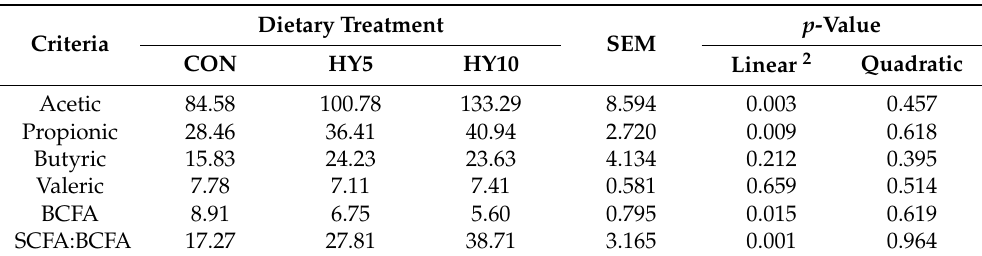
Table 7. Fecal short chain fatty acids ( µ mol/g of feces) contents of early weaned piglets fed HY- supplemented diet 1 . Criteria